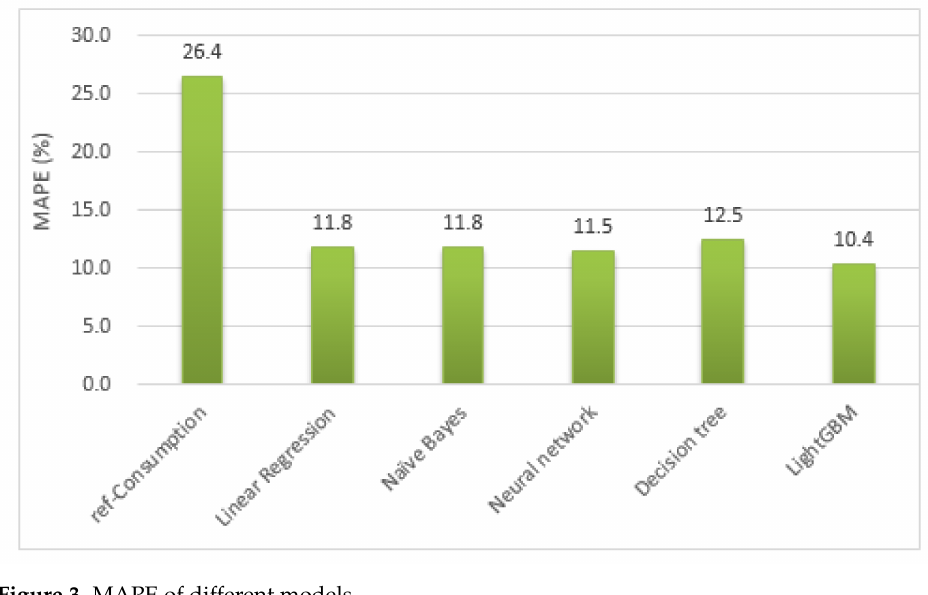
Figure 3. MAPE of different models.